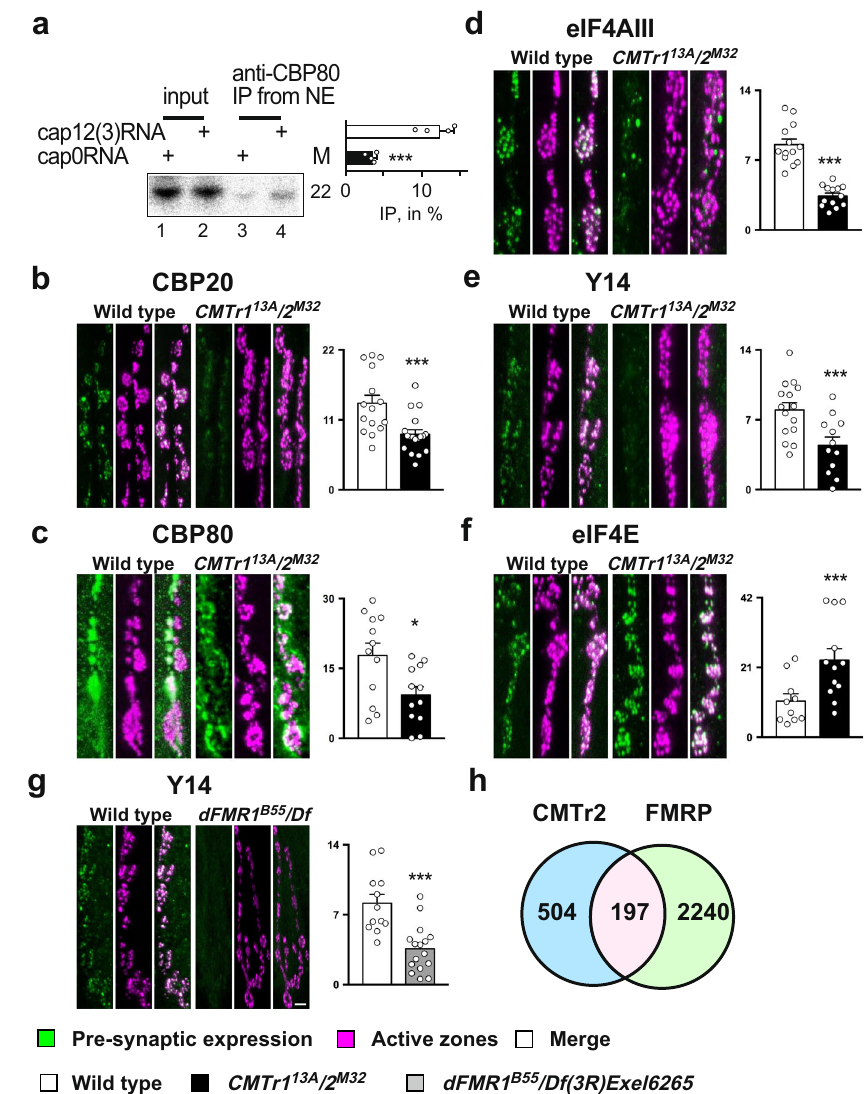
Fig. 5 2 ′ - O -ribose methylation of mRNA cap-adjacent nucleotides is required for localizing untranslated transcripts to synapses. a Immunoprecipitation of capped RNA with or without 2 ′ - O -ribose methylation from nuclear extracts. M: length in nucleotides. The graph to the right depicts the ratio of IP/input ( n = 4, p = 0.016). b – g Representative images from staining of synapses at third instar NMJs pre-synaptically expressing epitope-tagged markers with elav C155 - GAL4 from UAS or stained with an antibody (CBP80) in control (left, green) and CMTr1 13A ; CMTr2 M32 double mutant larvae ( b – f ) or dFMR1 B55 /Df3R ) Exel6265 mutant larvae ( g , right, green). The active zone of synapses was stained with nc82 (magenta). The mean±SE of the intensity is shown on the right is arbitrary units in white for the control, in black for CMTr1 13A ; CMTr2 M32 double mutant larvae ( b – f ) and in gray dFMR1 B55 / Df3R)Exel6265 mutant larvae ( g ) for nuclear cap-binding proteins CPB20 ( b , n = 16 and 19, *** p = 0.0015) and CBP80 ( c , n = 12, * p = 0.05), for nuclear exon junction complex (EJC) proteins eIF4AIII ( d , n = 13, *** p = 0.005) and Y14 ( e , n = 15 and12, *** p = 0.003), for the rate-limiting translation initiation factor eIF4E ( f , n = 10 and 12, *** p = 0.009) and for nuclear exon junction complex (EJC) protein Y14 in control and dFMR1 B55 /Df3R)Exel6265 mutant larvae ( g , n = 12 and 16, *** p = 0.005). The scale bar in g is 1 µ m. h Overlap (pink) of CMTr2 CLIP targets (blue) with FMRP targets (green) in Drosophila . Statistical analysis was done by an unpaired t -test. Source data for gel, immunoprecipitations values, and intensity of pre-synaptic bouton stainings are provided as a Source Data fi